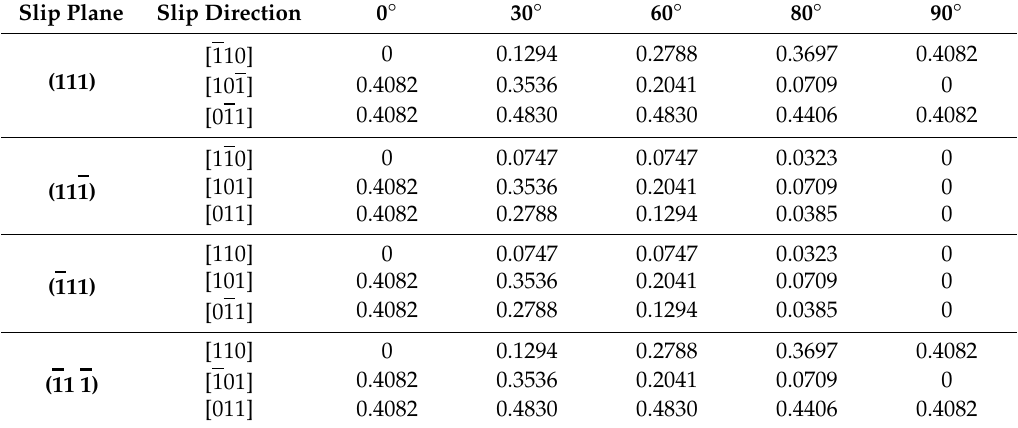
Table 1. Schmid factors of di ff erent slip systems under di ff erent misorientations in the Ni layer. Slip Plane